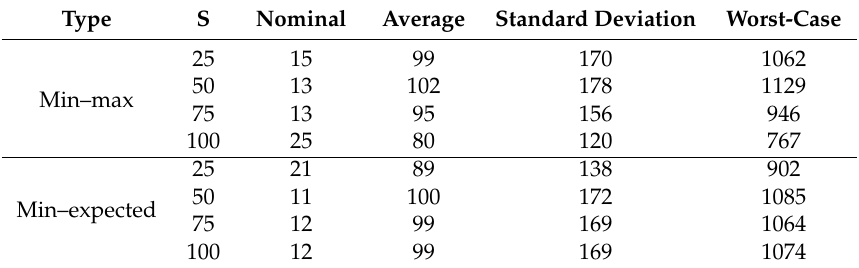
Table 2. The robust performance of the robust NMPC using different numbers of scenarios evaluated using 100 test scenarios.